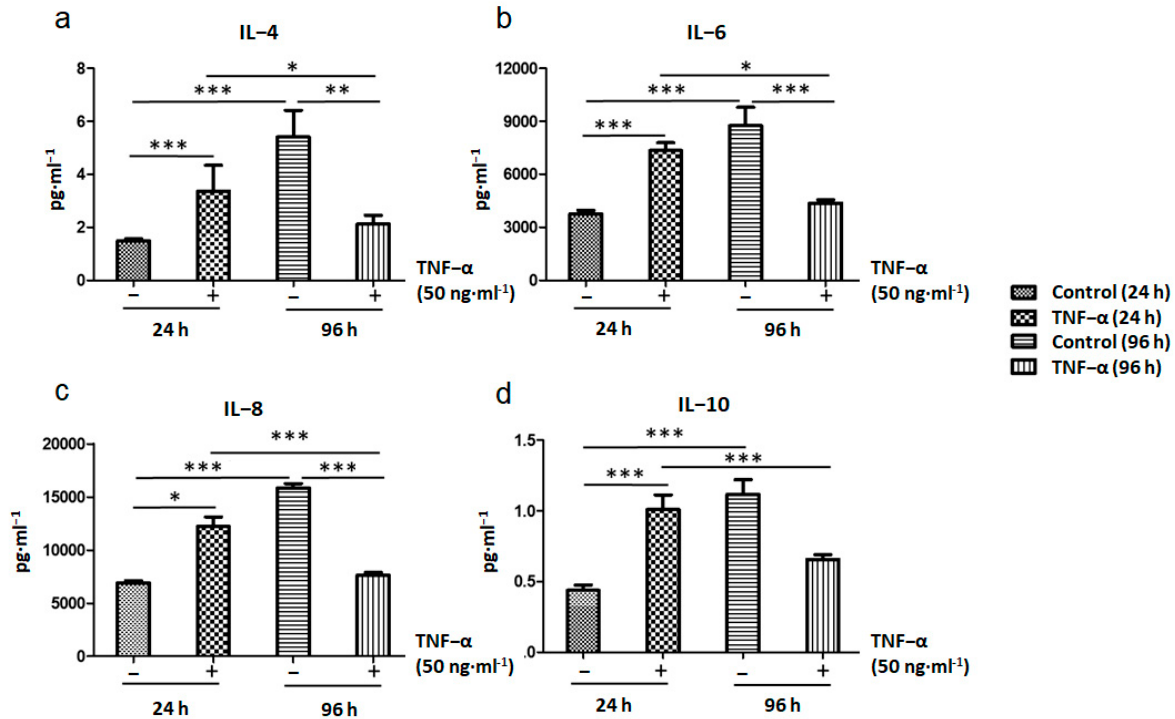
Figure 7. Inflammatory cytokine expression including ( a ) IL-4, ( b ) IL-6, ( c ) IL-8, and ( d ) IL-10 in TNF- α -treated ADSCs after 24 and 96 h (* p < 0.05, ** p < 0.01, *** p < 0.001).